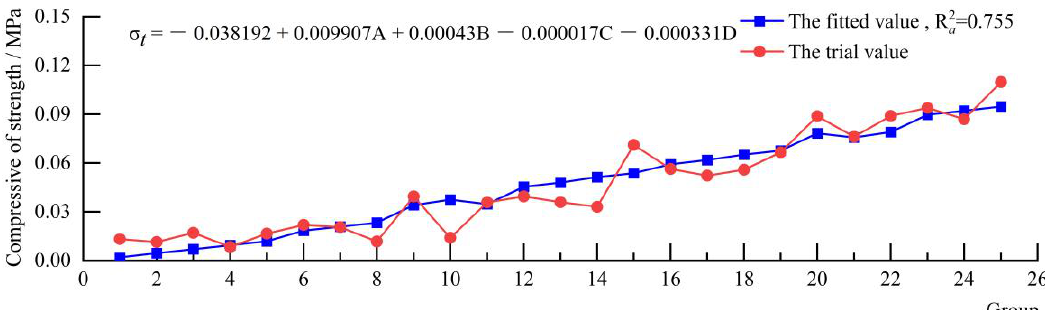
Figure 5. Comparison of fitted and experimental results for tensile strength.